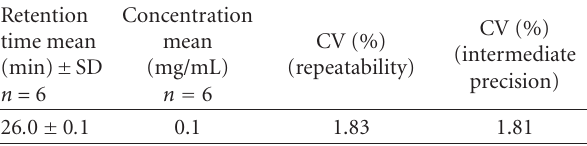
Table 2: Repeatability and intermediate precision of the HPLC method for the determination of hederacoside C in Ivy-Thyme cough